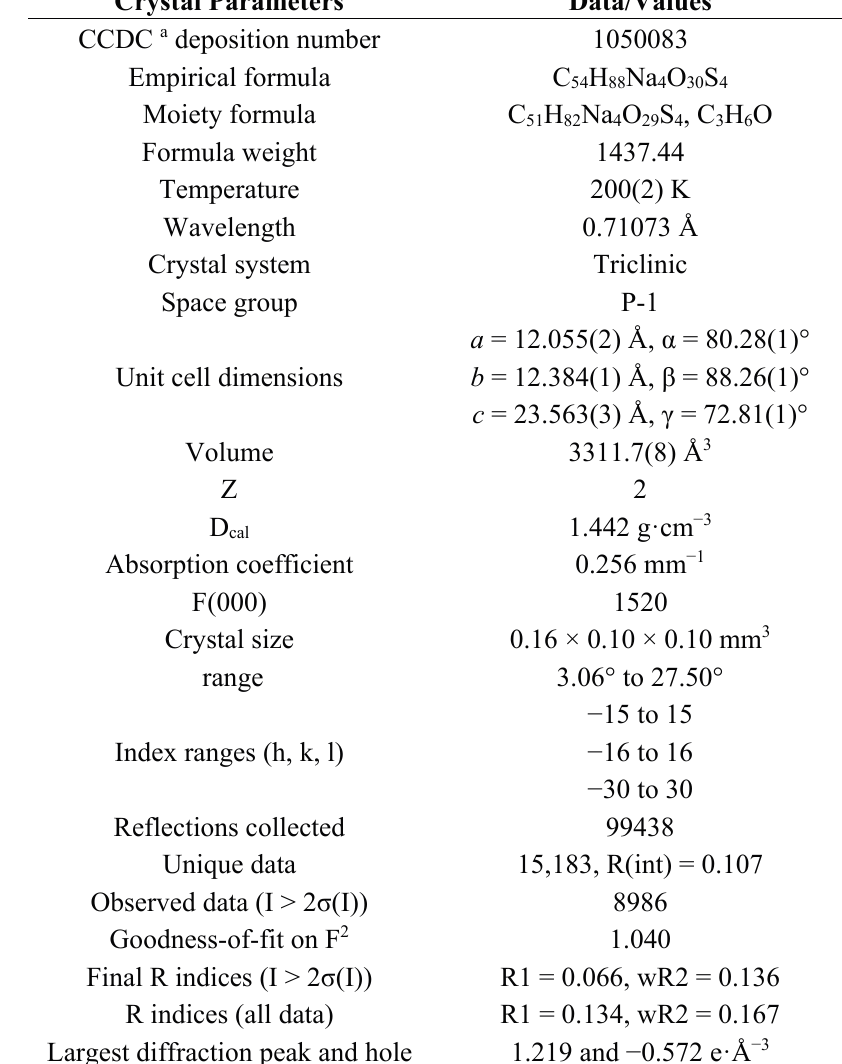
Table 4. Crystallographic data for compound 2a